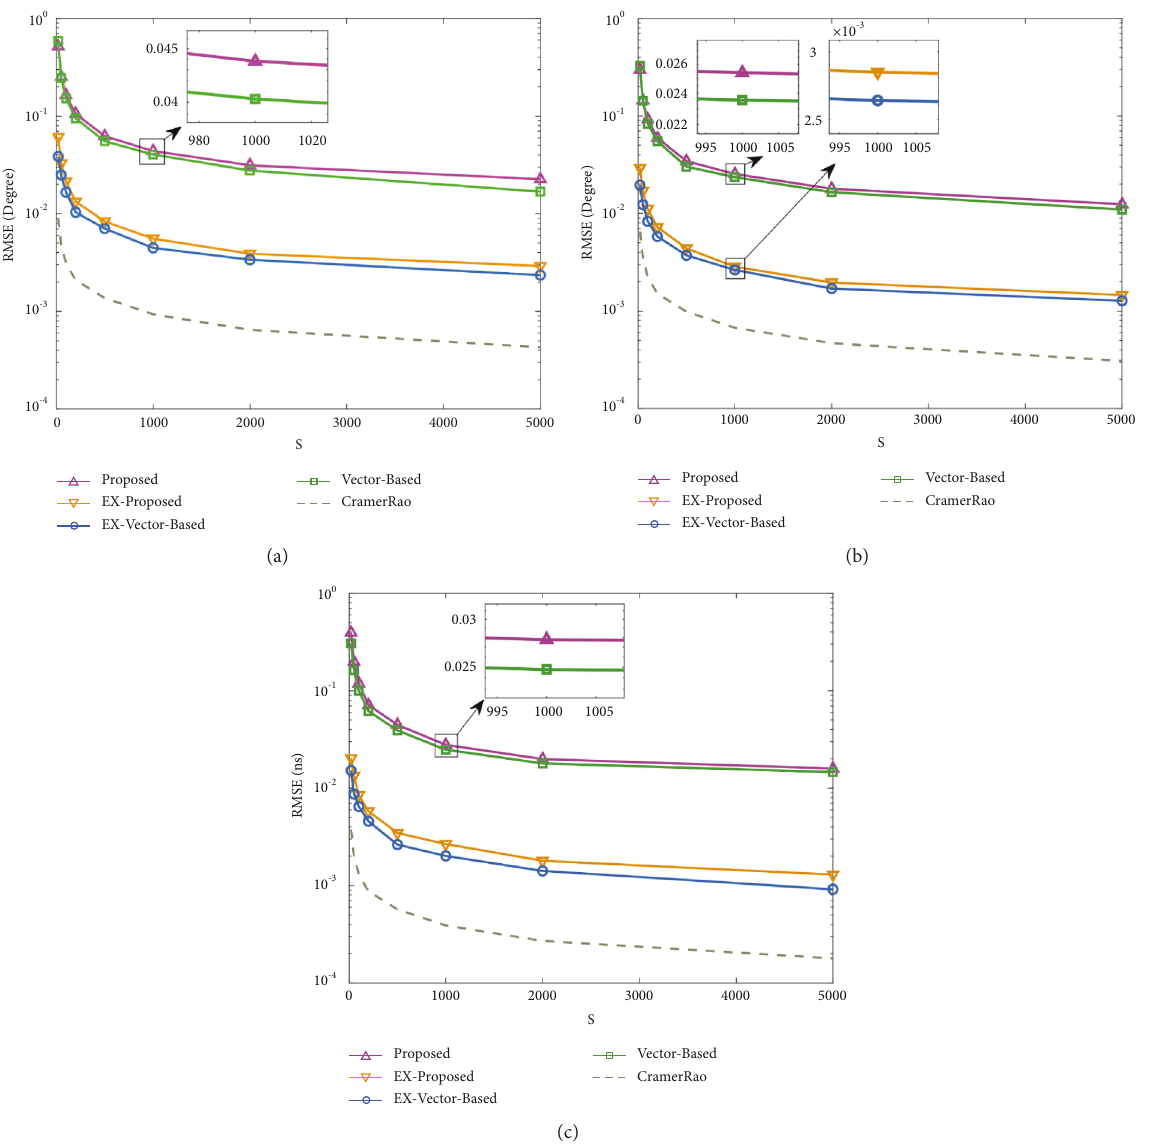
Figure 5: Performance comparison versus snapshots: (a) azimuth; (b) elevation; (c)